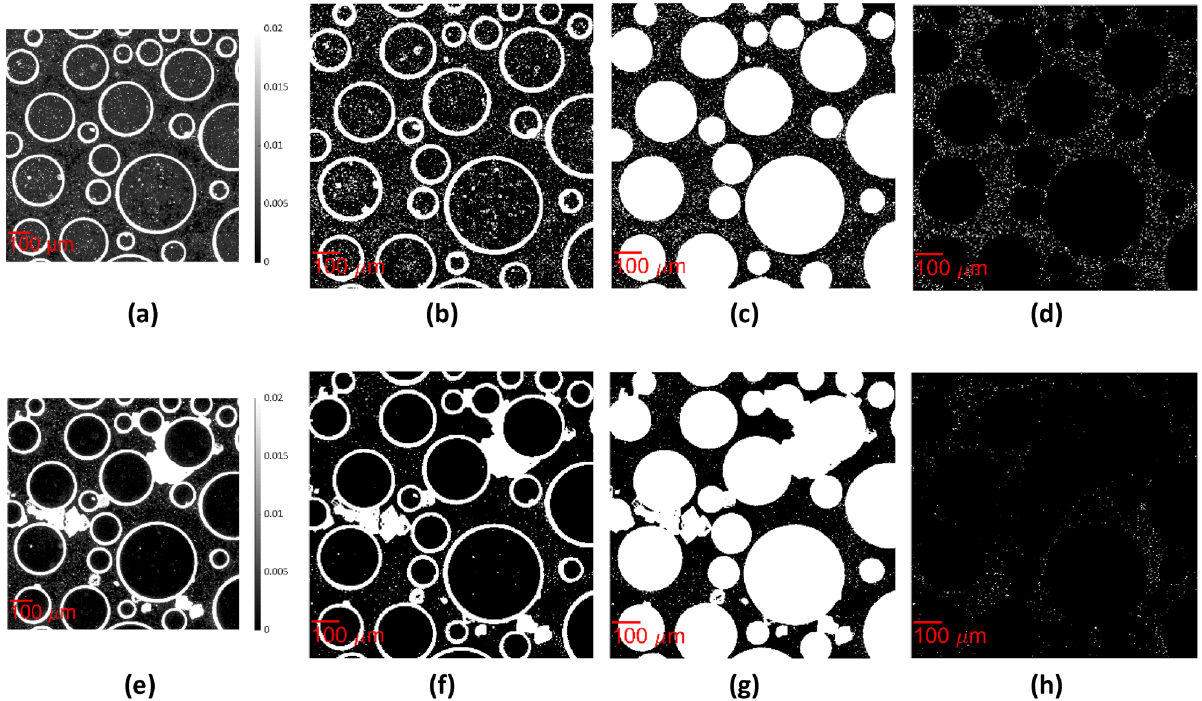
Figure 4. Workflow presenting the extraction of the binary image of bacteria from the phase contrast image at t = 0 ( a ) Section of dimensions 1.022 mm × 1.022 mm of the raw image of green channel; ( b ) Image binarization, ( c ) Set the pixels that correspond to the pillars in Fig. 3d to white, ( d ) Remove the pillars with “bwpropfilt”; at t = 10 ( e ) Raw image of green channel; ( f ) Image binarization, ( g ) Set the pixels that correspond to the pillars in Fig. 3d to white, ( h ) Remove the pillars with